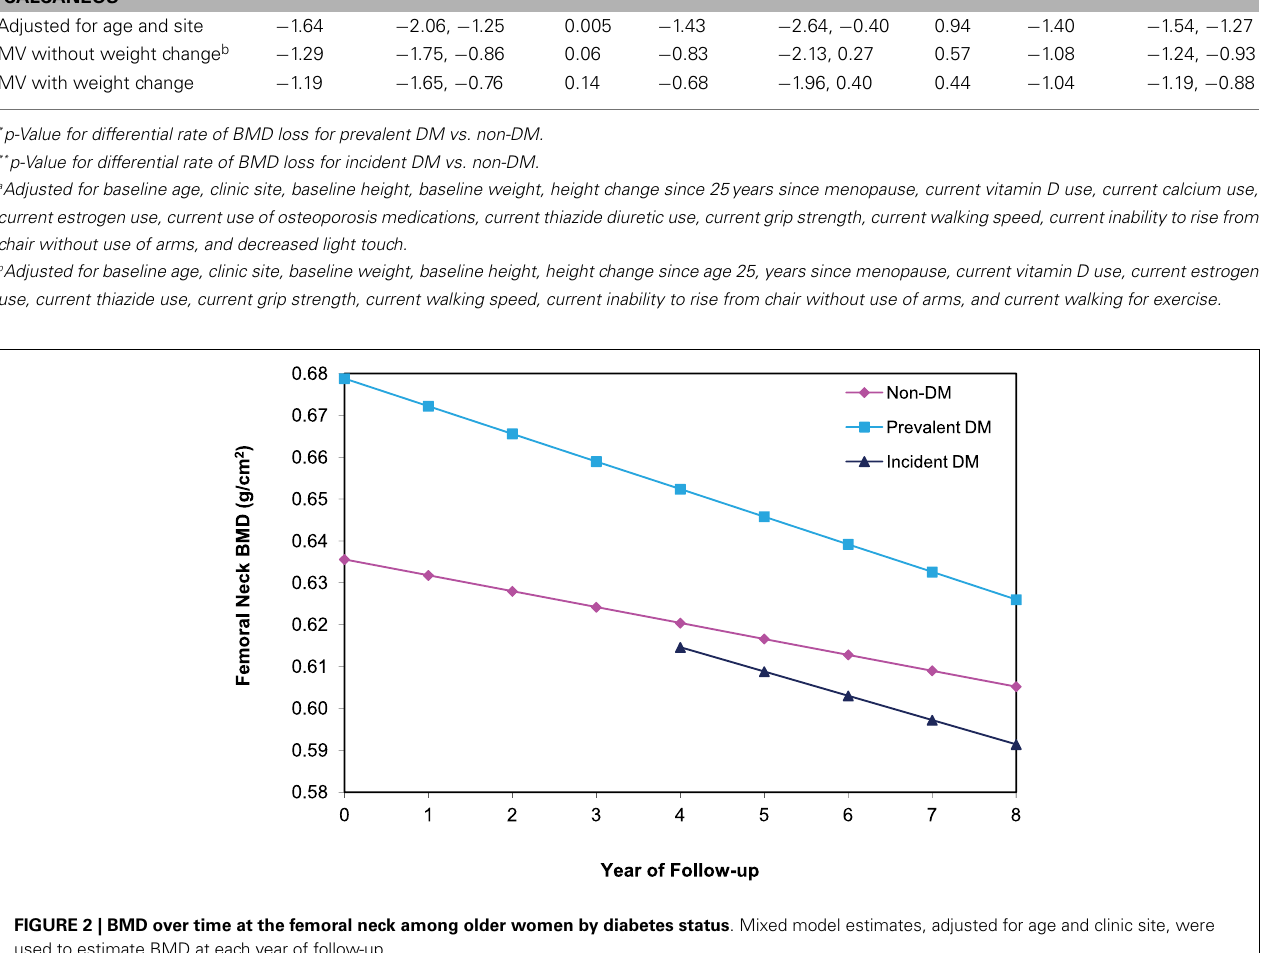
* p-Value for differential rate of BMD loss for prevalent DM vs. non-DM. **